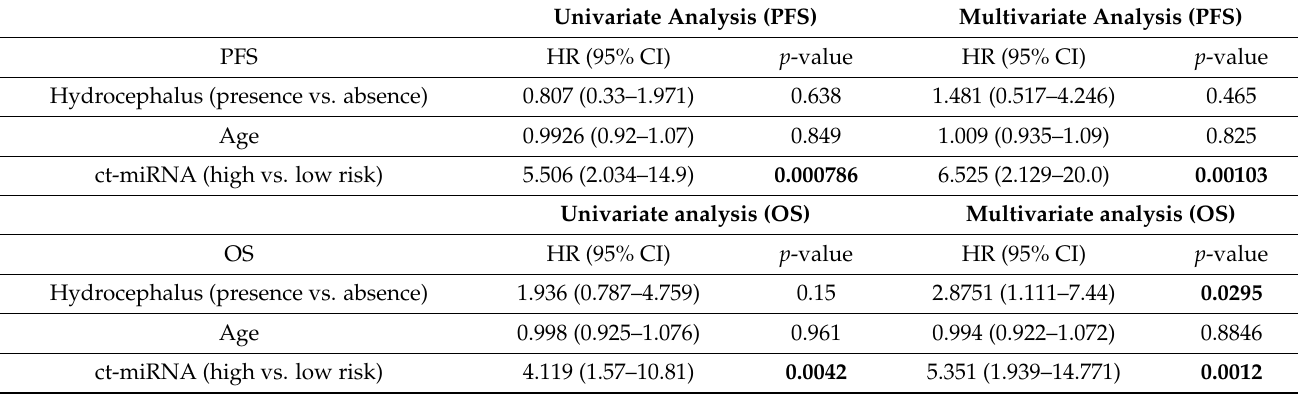
Table 2. Results of Cox’s proportional hazard regression